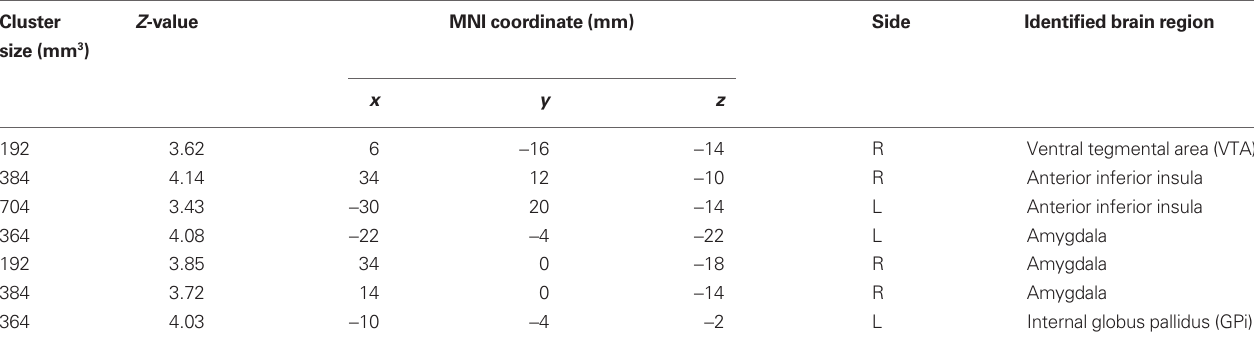
Internal globus pallidus